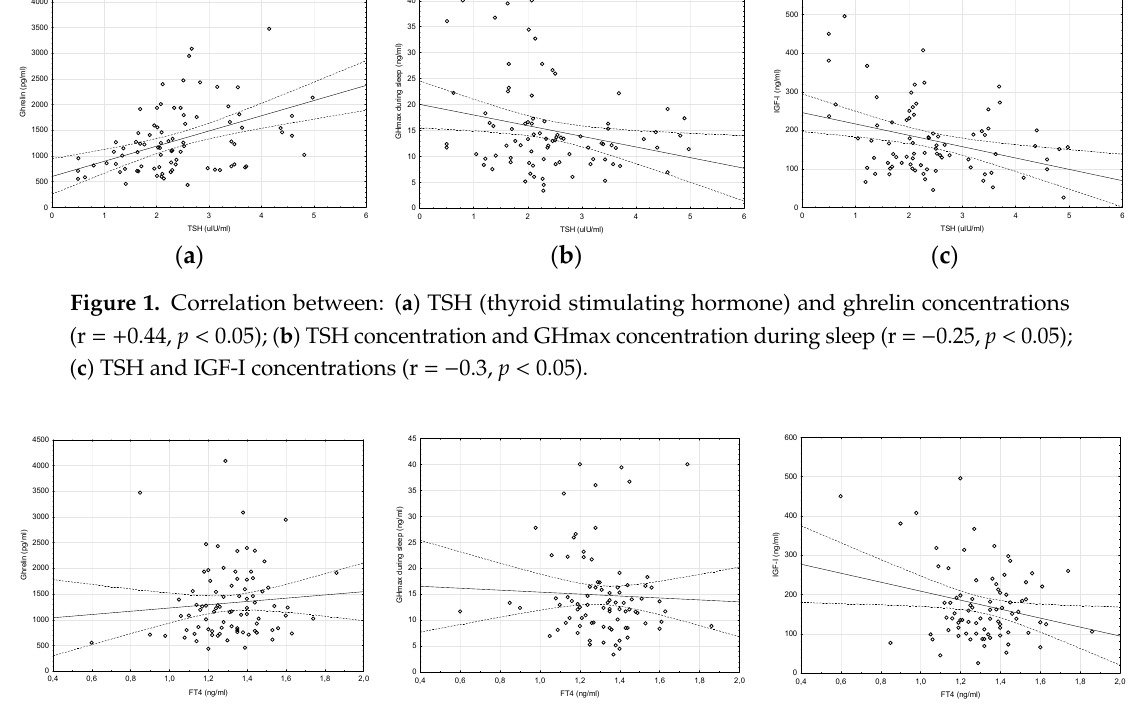
Figure 2. Correlation between: ( a ) FT4 and ghrelin concentrations (r = +0.08, p > 0.05); ( b ) FT4 and GHmax during sleep (r = − 0.04, p > 0.05); ( c ) FT4 and IGF ‐ I concentrations (r = − 0.19, p > 0.05).